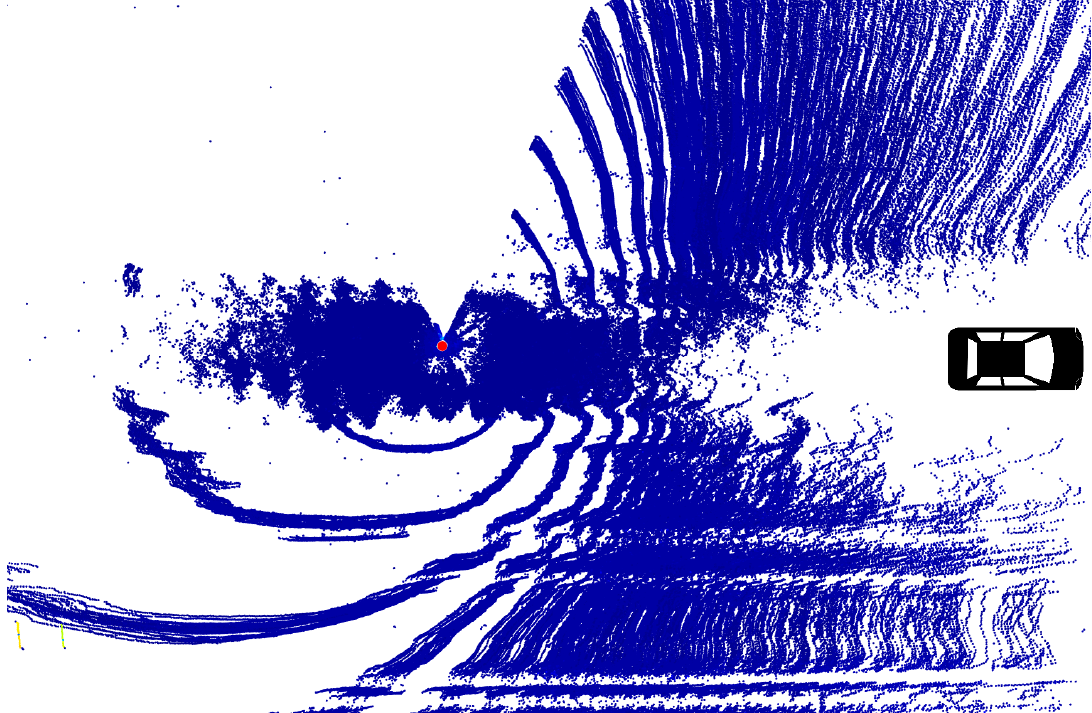
Figure 12. A Robosense point cloud when driving behind a leading vehicle.